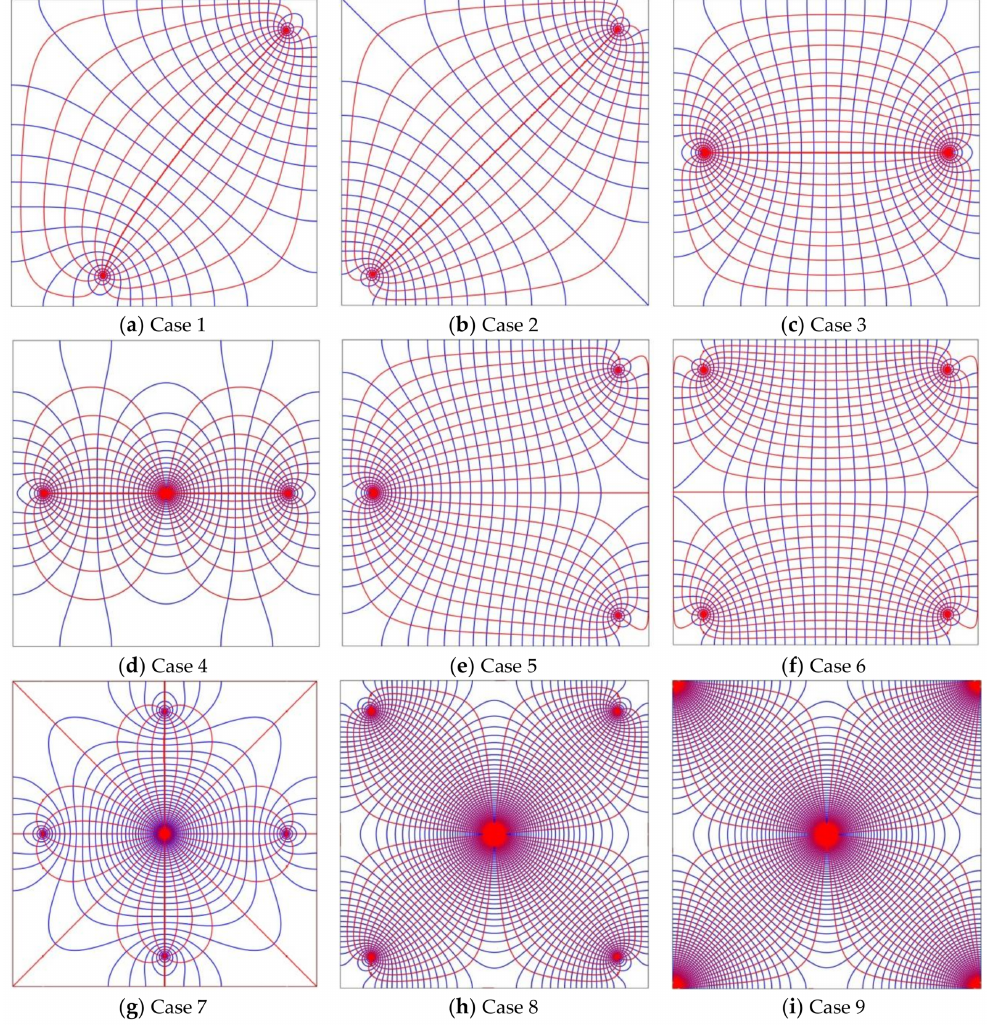
Figure 3. Predicted pore pressure contours (blue lines) and streamlines (red lines) for the nine well layout cases of enhanced geothermal systems shown in Figure